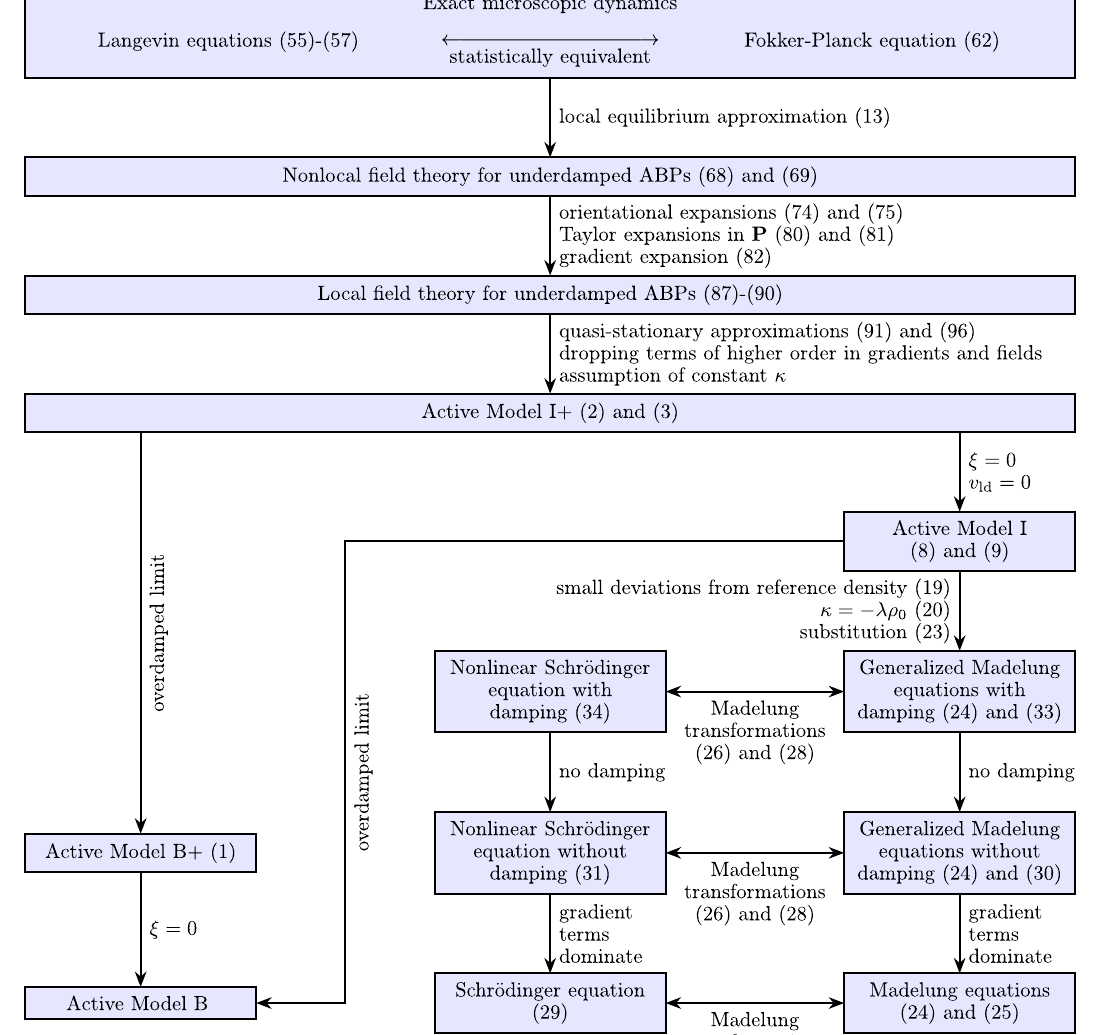
More general models are obtained by omitting some approximations. Active models I and I+ contain an analog of the Schrödinger equation as well as the overdamped active models B and B+ as limiting